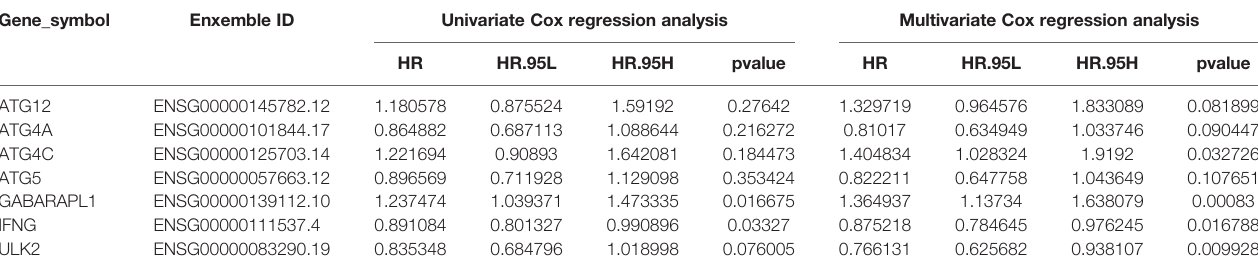
TABLE 2 | Univariate and multivariate COX regression analysis results of 7 immune